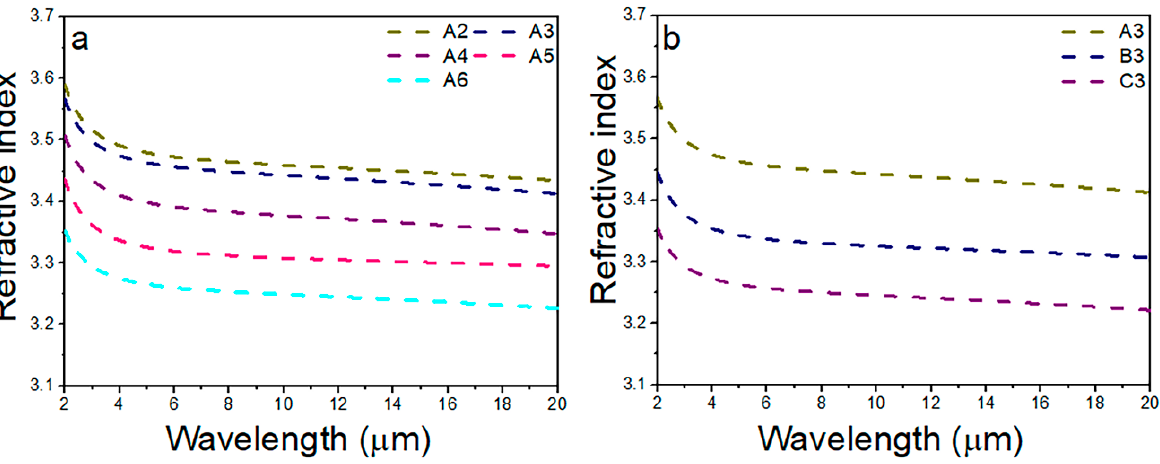
Figure 6. The linear refractive index of GAST glasses: ( a ) A2–A6: Se 5 (Ge 0.1 As 0.9- x Te x ) 95 ( x =0.7-0.3), ( b ) A3–C3: Se y (Ge 0.1 As 0.3 Te 0.6 ) 100- y ( y =5, 10, 14)